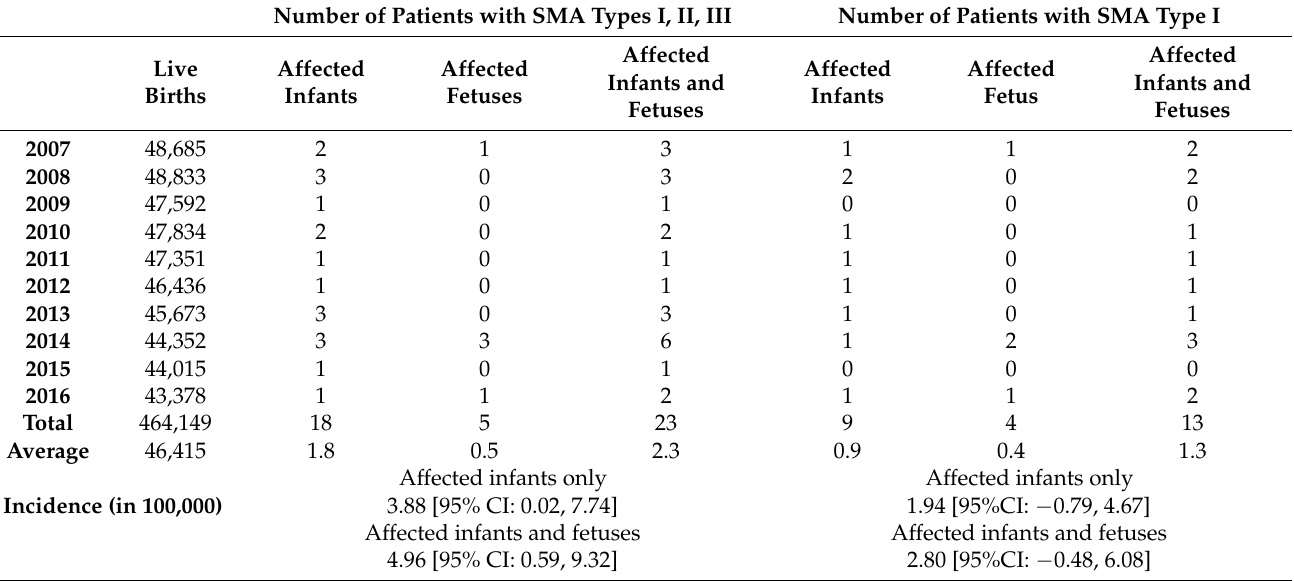
Table 2. Incidence of SMA patients in Hyogo Prefecture. Number of Patients with SMA Types I, II,